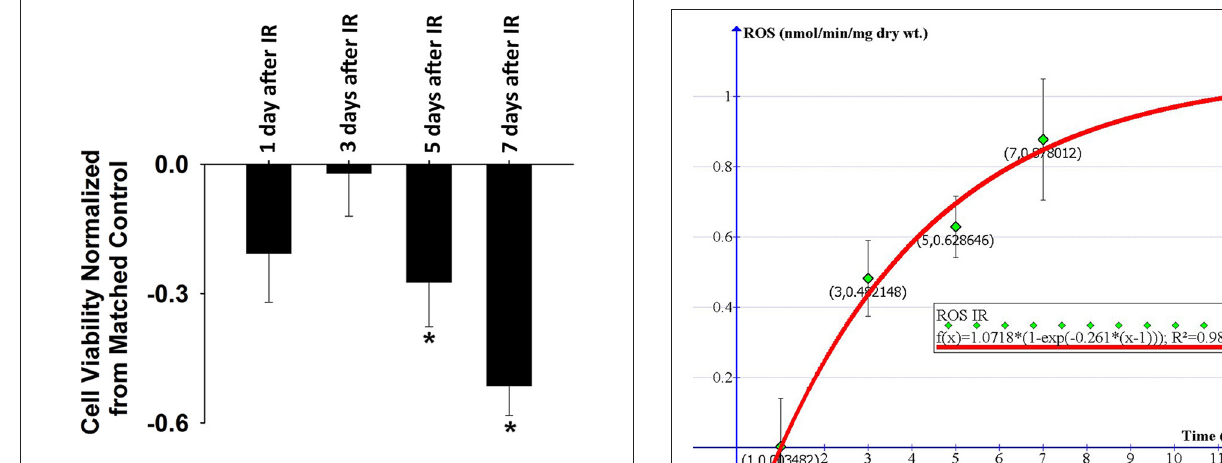
FIGURE 5 | Normalized cell viability evaluated by Cellometer Mini on day 1, 3, 5, and 7 after IR. Each data was normalized by the corresponding control data based on the following equation: normalization = (IR-control)/control ( n = 6 per treatment). *Significant difference between IR treatment and matched control on the same day. Sig. (2-tail); p < 0.05.